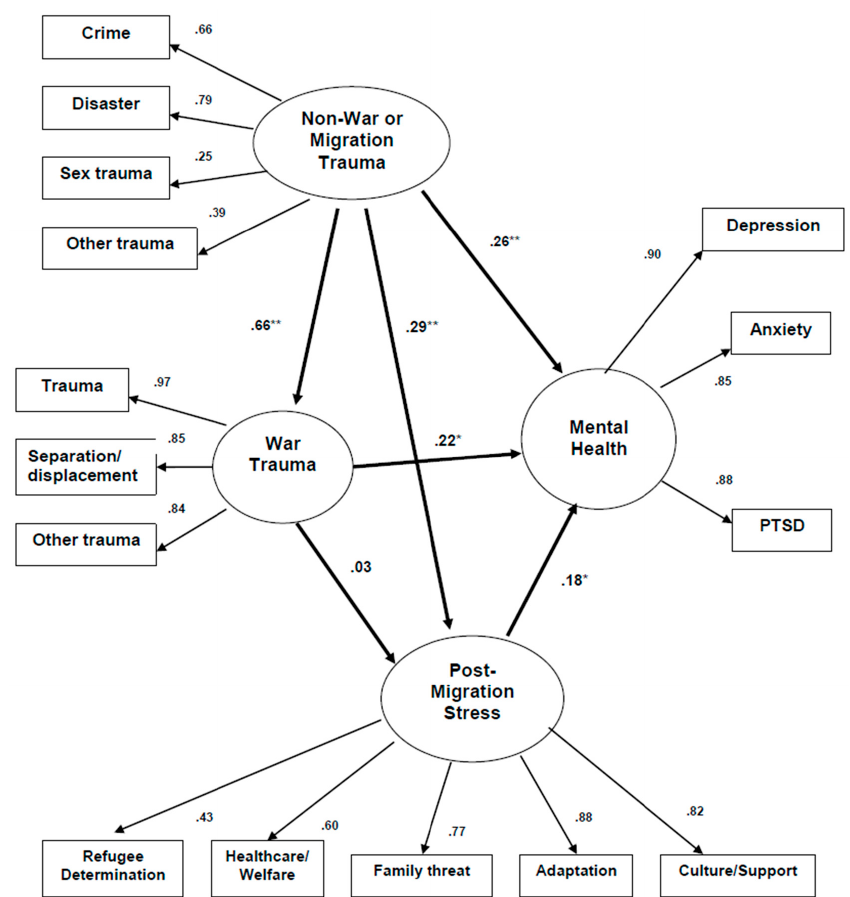
Figure 2. Predicting Mental Health from Various Sources of Trauma: Vietnamese ( N = 135, Standardized Regression Weights and Factor Loadings). ** P < 0.01; * P < 0.05; Full Model: χ 2 = 145.1, DF = 84, p < 0.001 RMR = 1.29; GFI = 0.93, AGFI = 0.90.